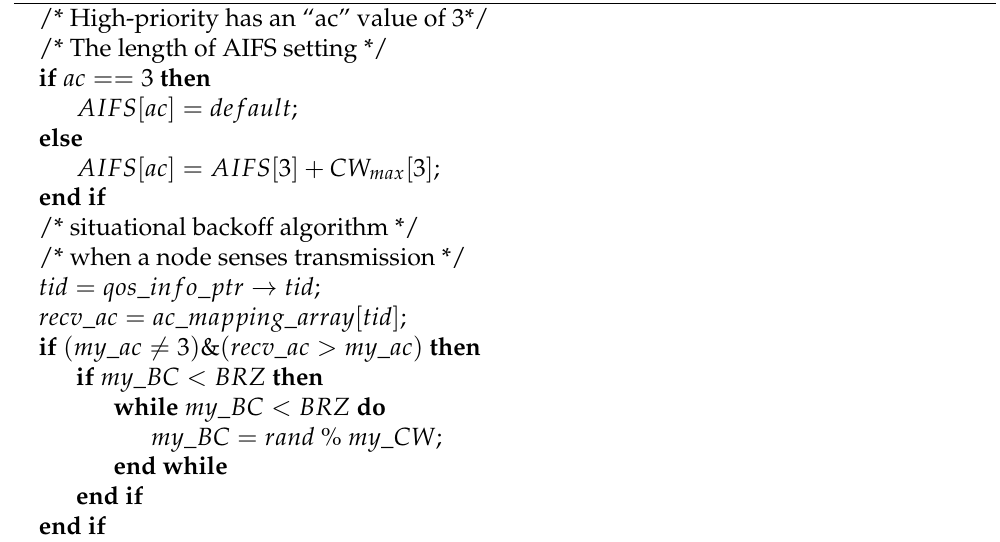
Figure 2. QoS data frame structure. Algorithm 1 Pseudocode of situational backoff